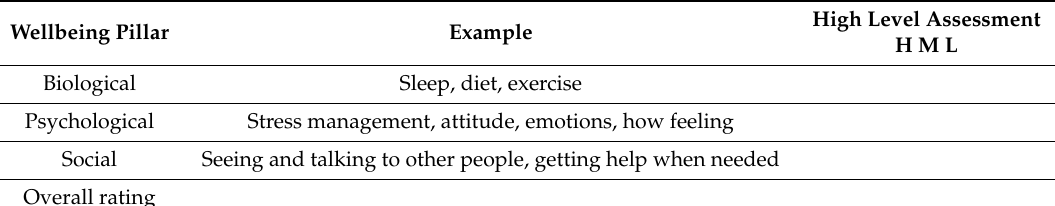
Table 8. Wellbeing assessment: three pillars. H = high, M = medium, L =